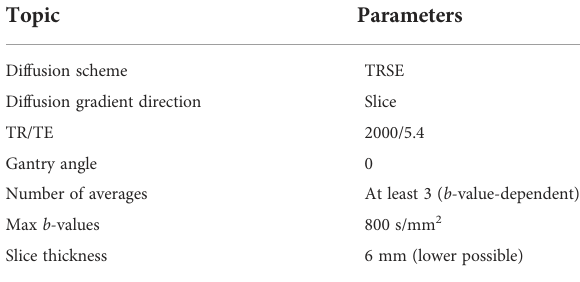
TABLE 7 Acquisition parameters for ADC measurements.